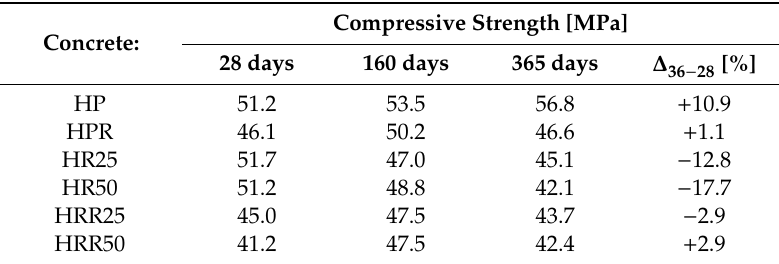
Table 3. Compressive strength at di ff erent ages.